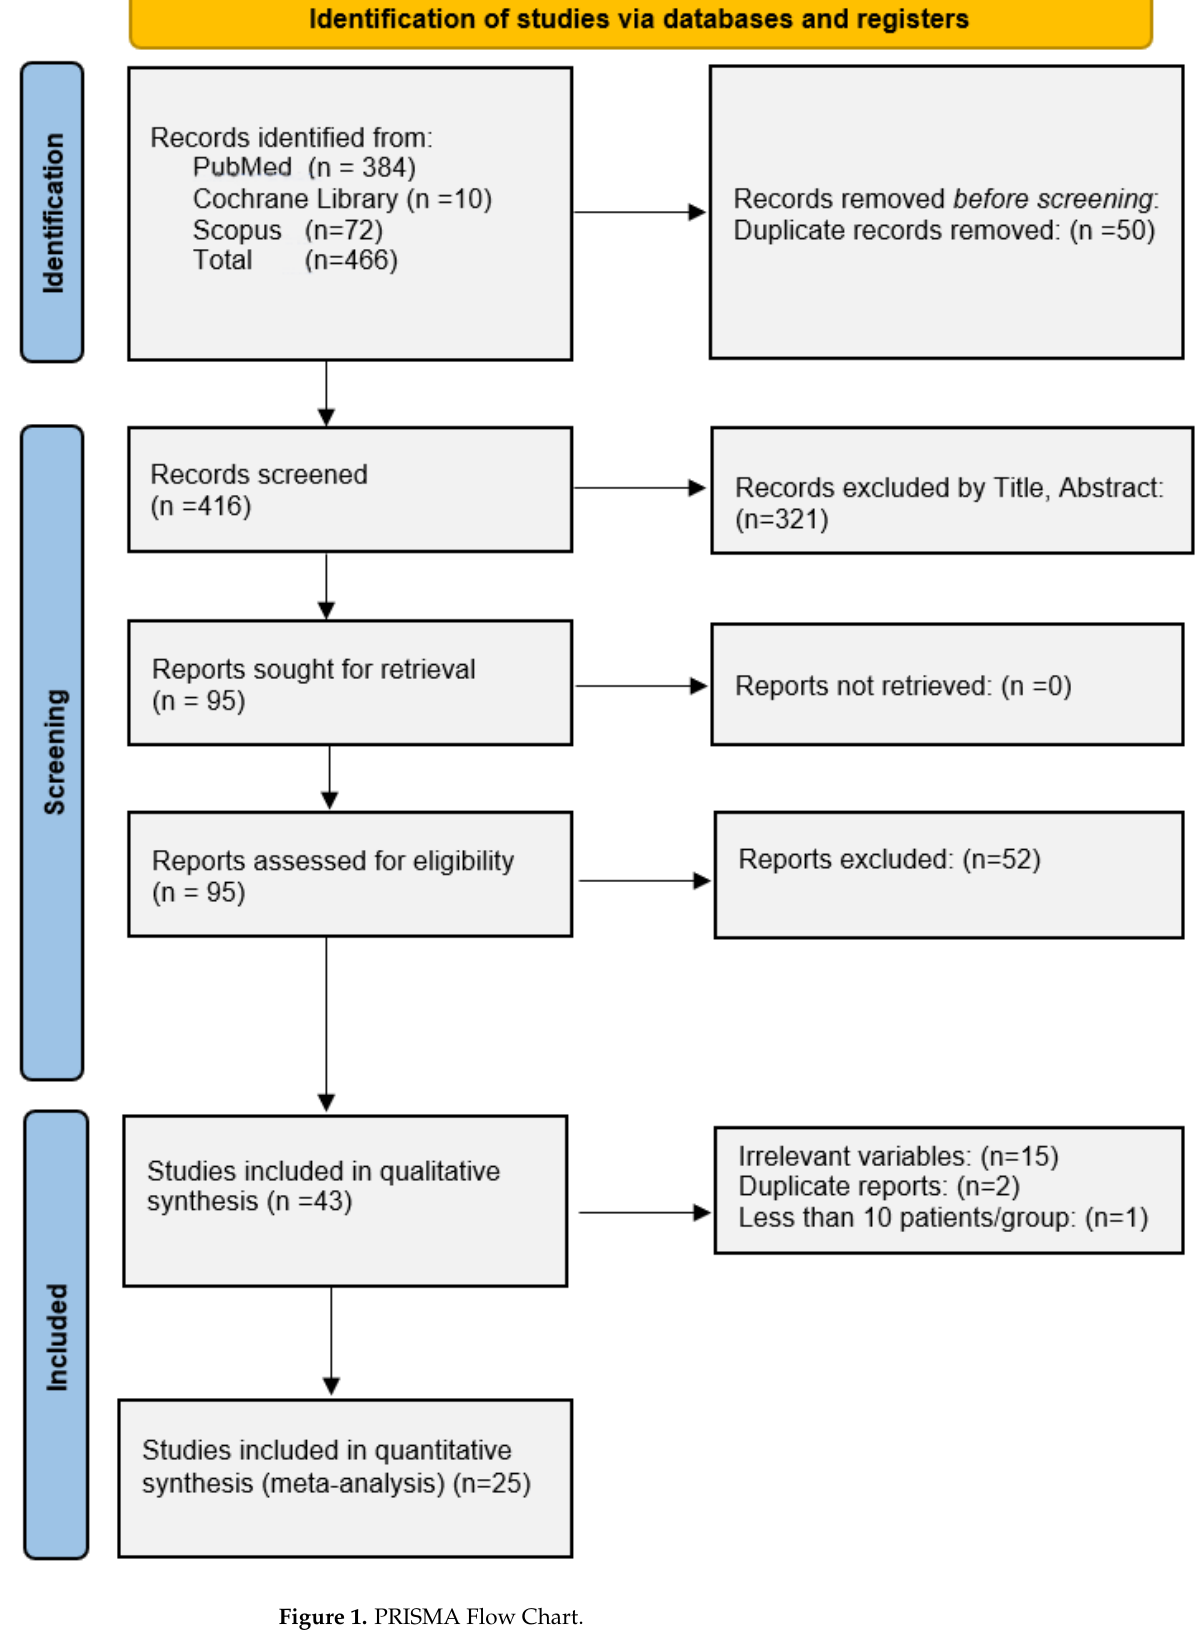
Figure 1. PRISMA Flow Chart .